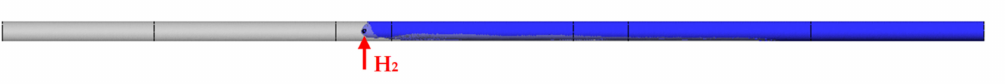
Figure 6. Display of the result of the numerical simulation in the USP tube, taking into account the temperature (blue—H 2 profile, grey—N 2 profile).